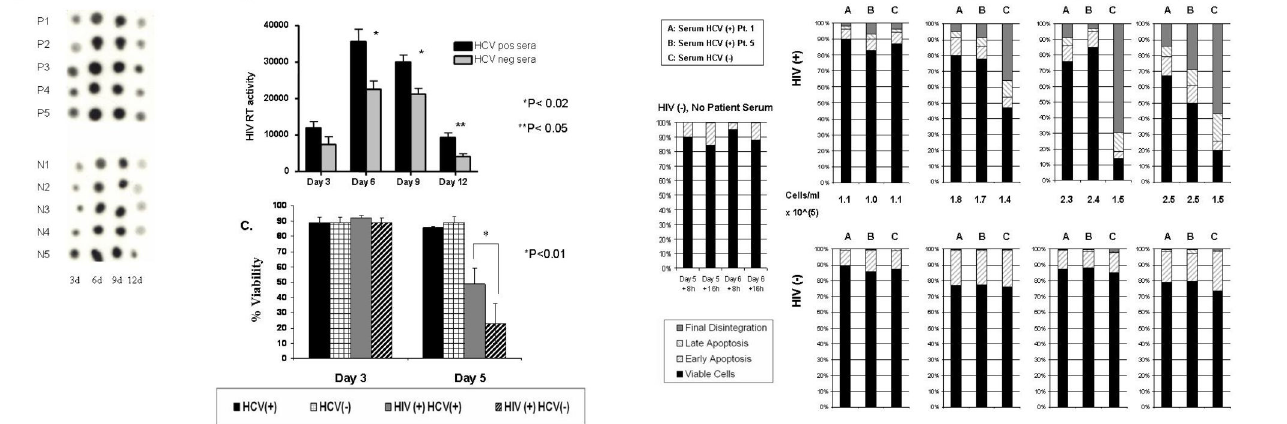
Figure 2. Infection of Daudi-CD4 cells with HIV. (A) Cells were infected with HIV (pNL4-3) and incubated with either HCV-positive patient serum (P1-P5) or HCV-negative serum (N1-N5) as described in Materials and Methods. Supernatant was harvested on days 3, 6, 9, and 12 and assayed for RT activity. Assay samples were spotted onto DEAE paper and visualized with autoradiography. (B) RT assay results quantified using densitometry. HIV RT activity is measured in arbitrary units. (C) To measure apoptosis resulting from exposure to HIV and HCV, cells were mock HIV-infected or infected with HIV then incubated with patient serum either positive or negative for HCV On days 3 and 5, cells were harvested, stained with annexinV (AV) and propidium iodide (PI), fixed, and measured for viability by flow cytometry. Viability was determined by the percentage of cells negative for both AV and PI. This experiment used 6 HCV-positive and 5 HCV-negative patient sera. Shown are the mean values ± SEM.